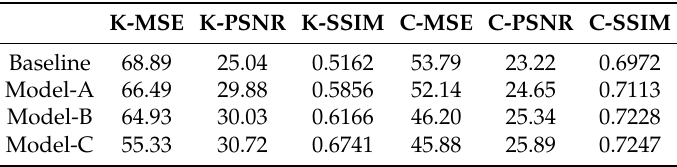
Figure 14. Virtual view reconstruction based on polluted images. The black area in the left image simulates flying insects or mud. The bottom row shows the detail of regeneration. Table 7. Quantitative comparisons on polluted image